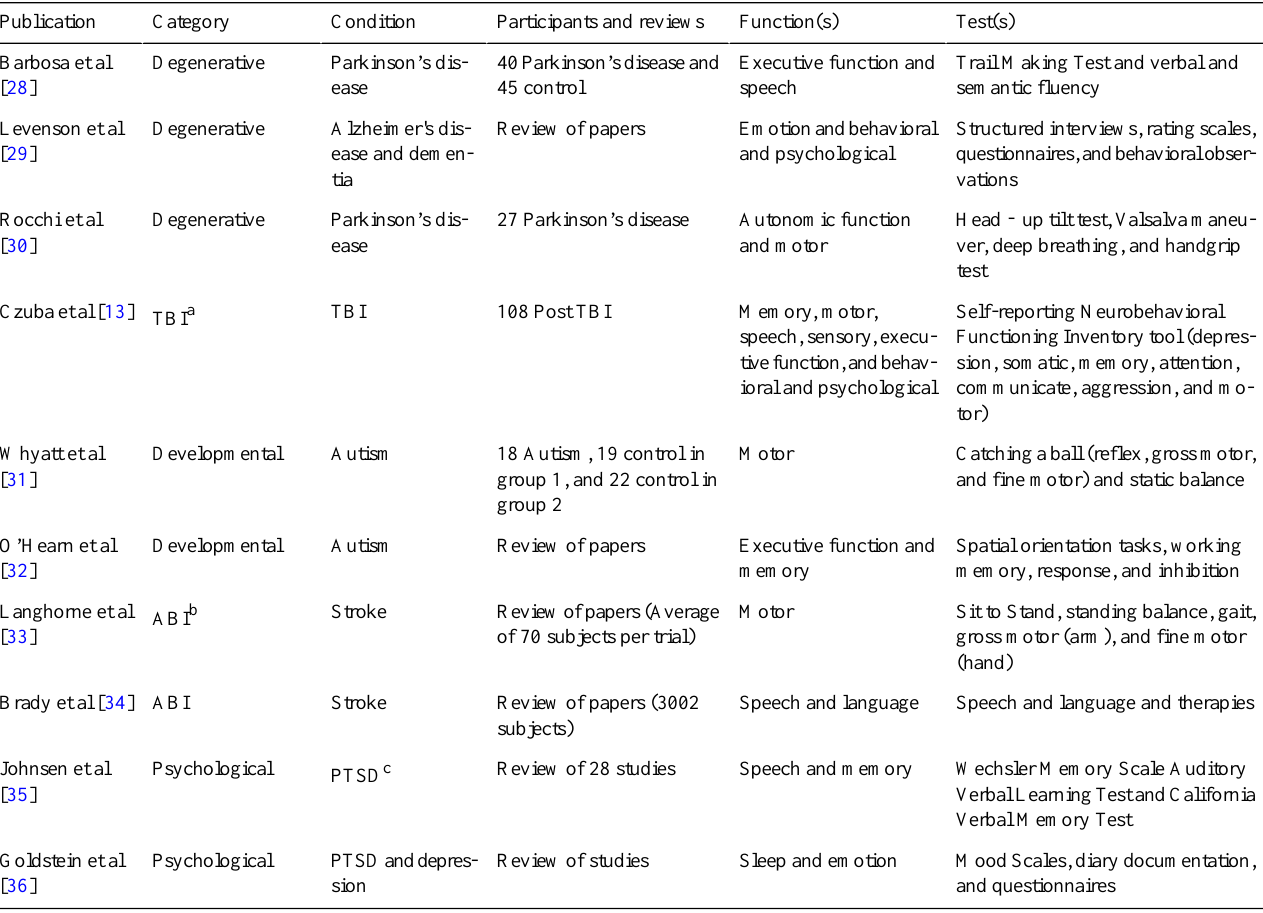
Table 3. Collection of relevant studies for traditional